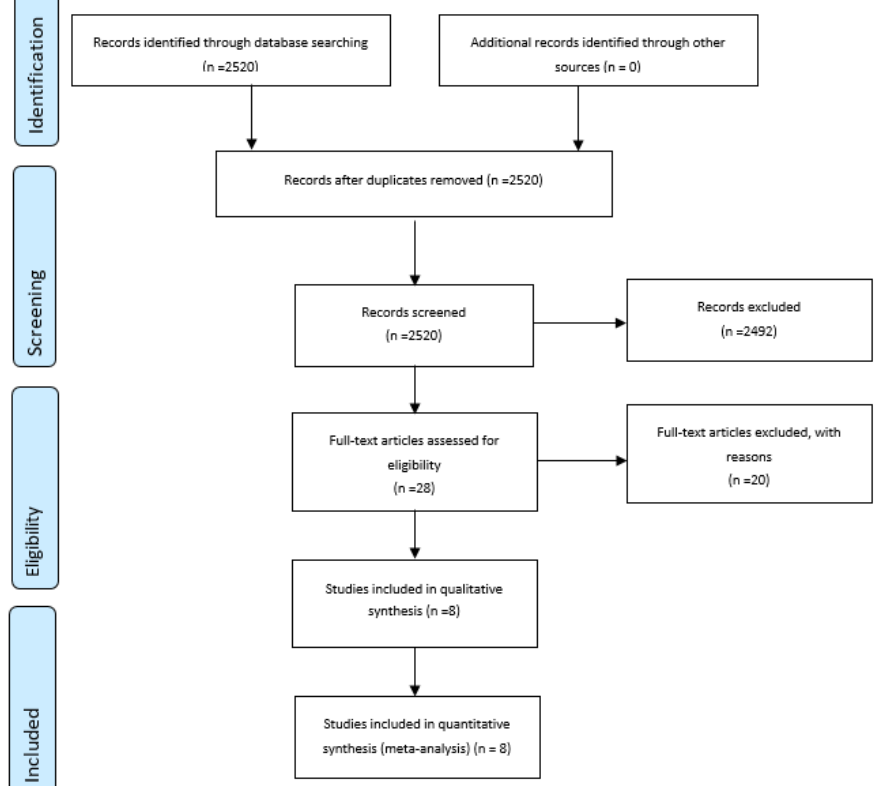
Figure 1. Selection process for the systematic review and meta-analysis.